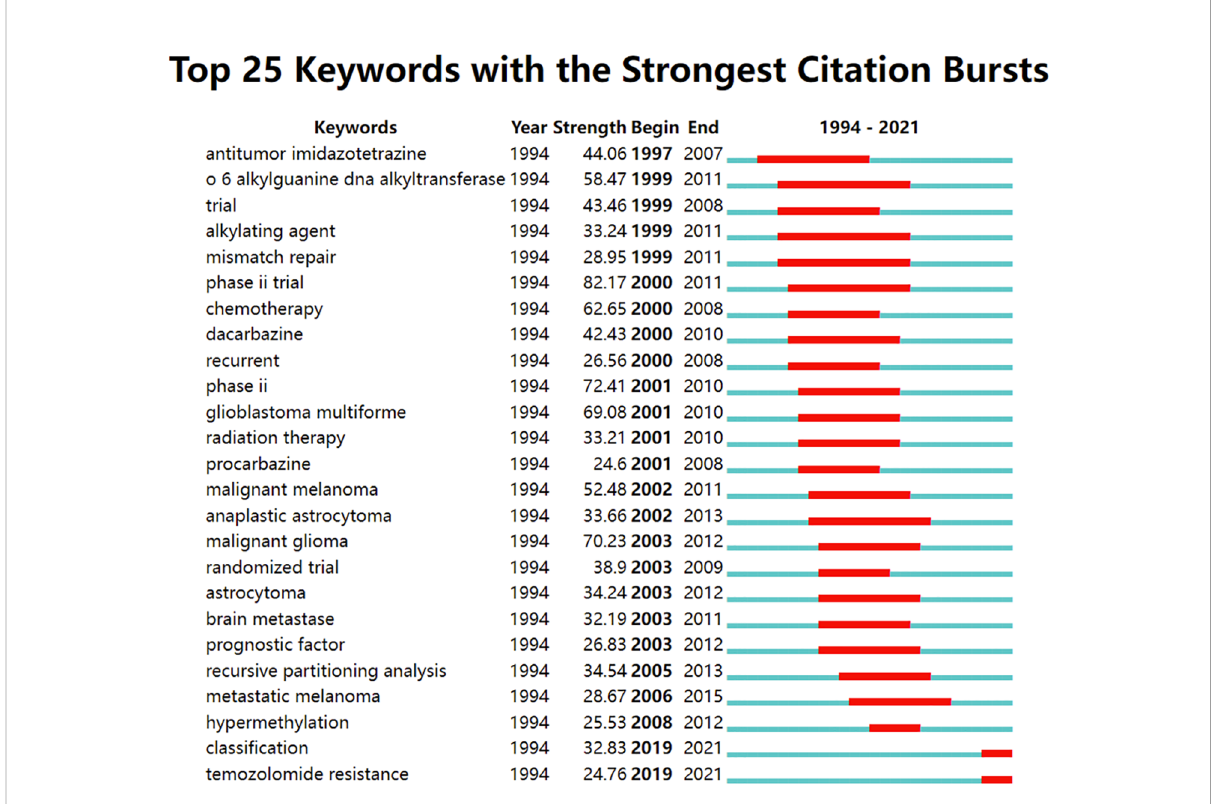
FIGURE 12 The burst detection of keywords of TMZ area in chronological order,